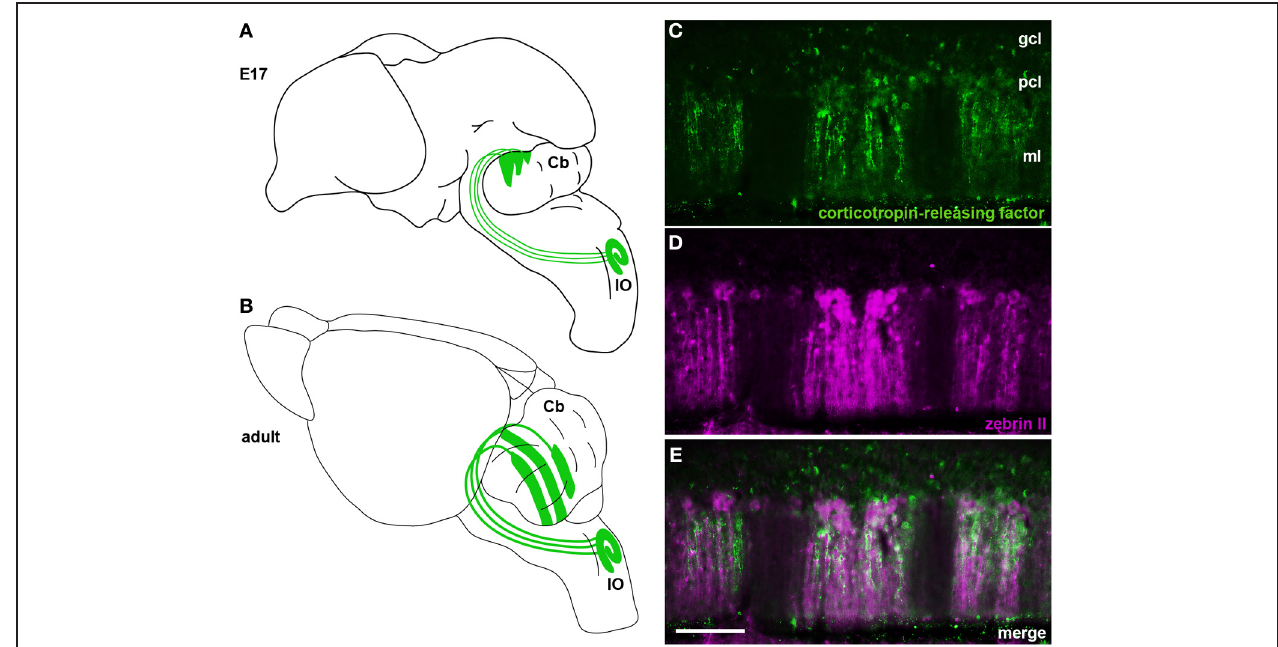
FIGURE 4 | (A) Schematic illustrating climbing fibers projecting from the inferior olivary nucleus (IO) to the cerebellum (Cb) and their organization into a crude zonal pattern at E17. (B) A schematic of the adult brain showing climbing fibers projecting from the inferior olive (IO) to well-defined Purkinje cell zones in the cerebellum. (C–E) In the adult cerebellum corticotropin-releasing factor (CRF) is expressed in subsets of climbing fibers that align with zebrin II